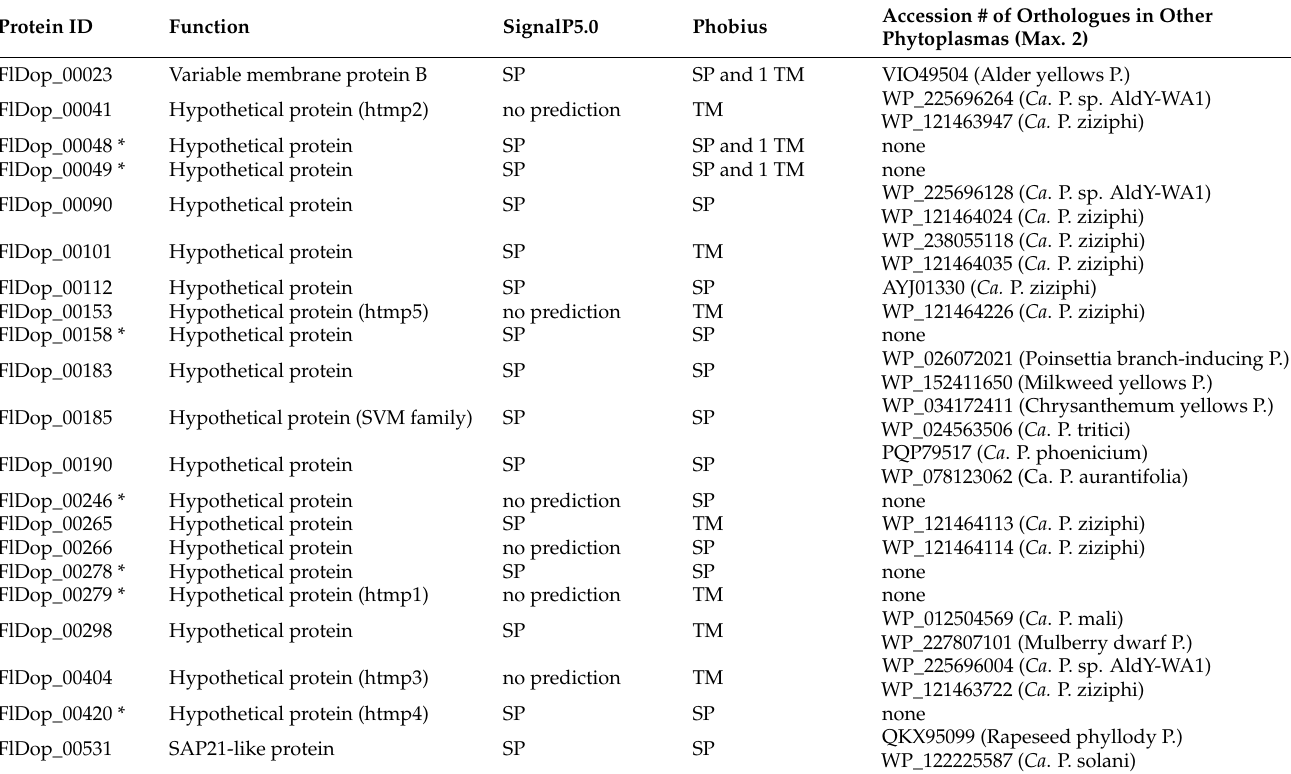
Table 2. Putative effectors encoded by the FDp